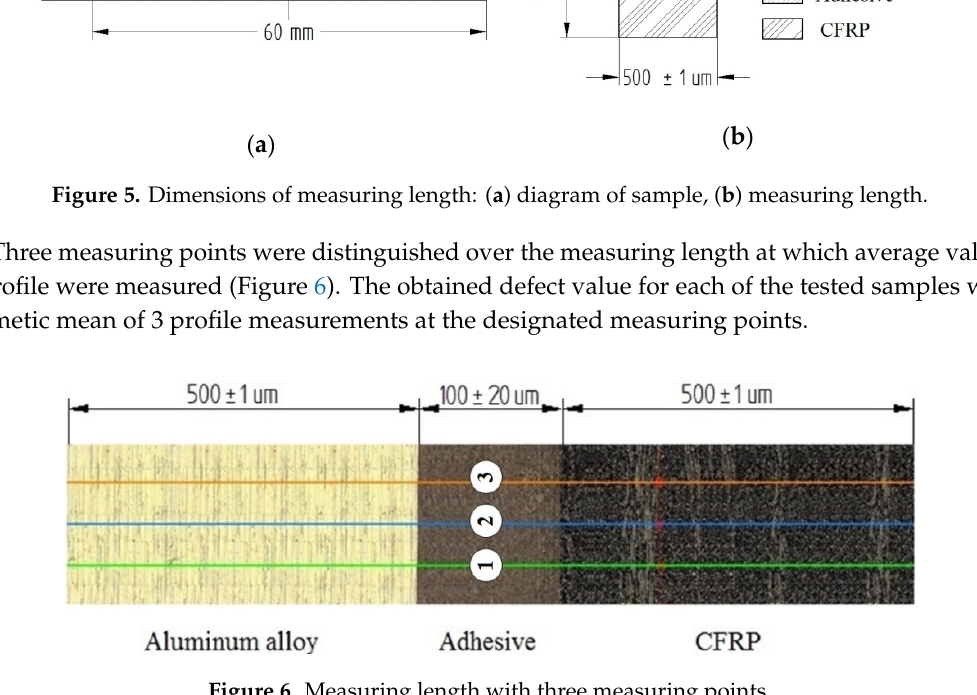
Figure 7. Method of determining the value of defect. In order to define the value of the defect, the height of the cross profile of the unevenness (average value of 3 measurements) formed on the surface of the composite (X CFRP ) and aluminum alloy (X Al ) layers was determined (Figure 7). The distance between the heights was adopted as a defect after milling process (X) and was calculated by: 𝑋 (cid:3404) |𝑋 (cid:3004)(cid:3007)(cid:3019)(cid:3017) (cid:3398) 𝑋 (cid:3002)(cid:3039) |